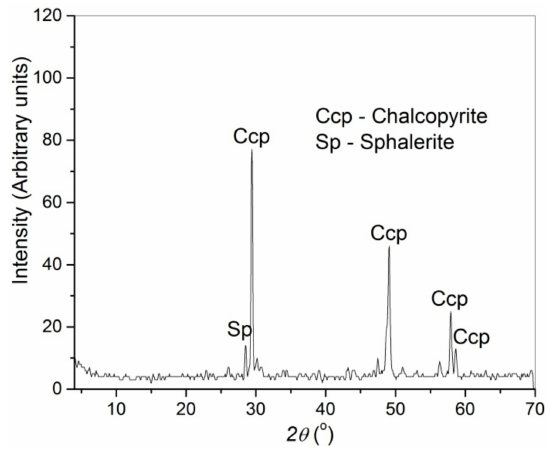
Figure 1. X-ray di ff raction analysis of the chalcopyrite concentrate sample [56].